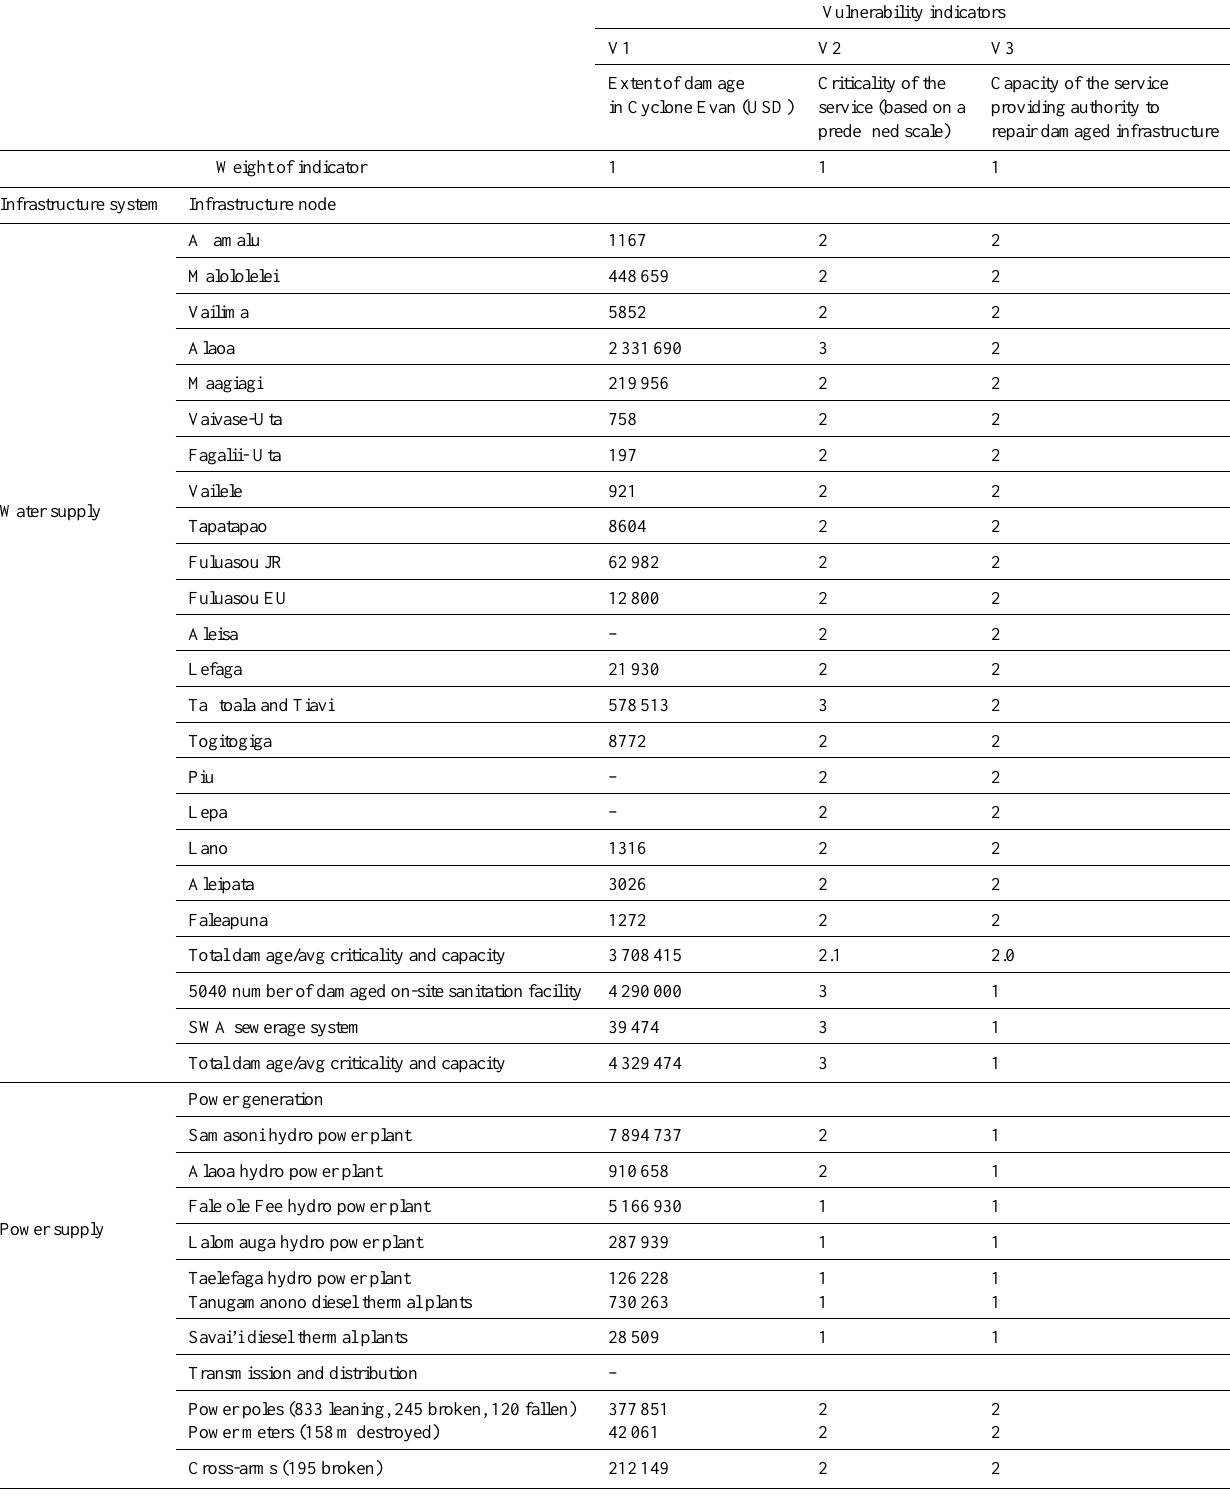
Table 5. Vulnerability raw data based on stakeholders,